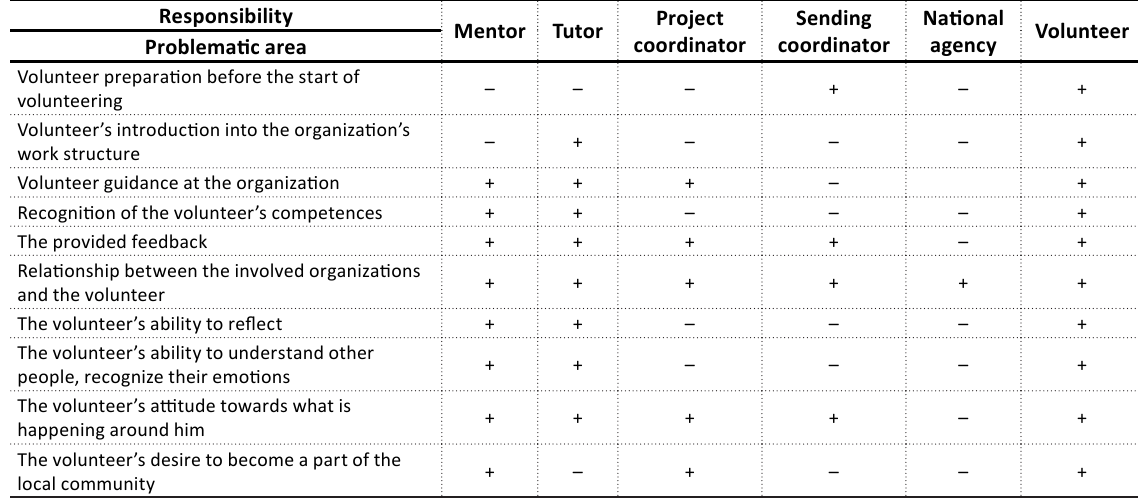
Table 2. Allocation of responsibilities in order to ensure adequate volunteer guidance